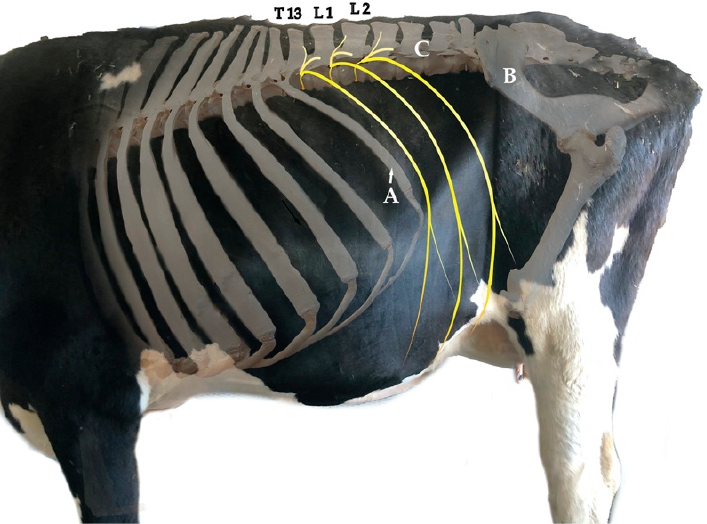
Figure 1. Superposed photographs from the left lateral view showing part of the skeleton, the trunk and limbs. The targeted spinal nerves for the proximal paravertebral nerve block are T13, L1 and L2, which are drawn in yellow. The flank is delimited cranially by the 13th rib (A), caudally by the Ala ossis ilii (B) and dorsally by the transverse processes of the lumbar vertebrae (C). Credits to C.A.R. Dissection of the dorsal region provides an overview and the anatomical organization of the spinal nerves. The spinal nerves found in this region are T13 and L1–L6, which leave the Medulla spinalis through the Foramen intervertebrale placed caudally to the corresponding vertebra. The spinal nerves are formed by a sensitive dorsal and a motor ventral root, which unite before going through the Foramen intervertebrale to build the Truncus nervi spinalis (Figure 2).